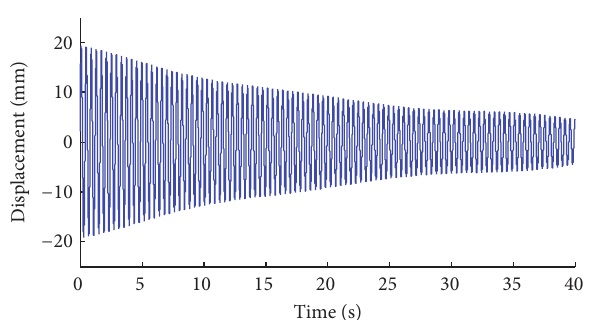
Figure 13: Displacement time history of cable model free